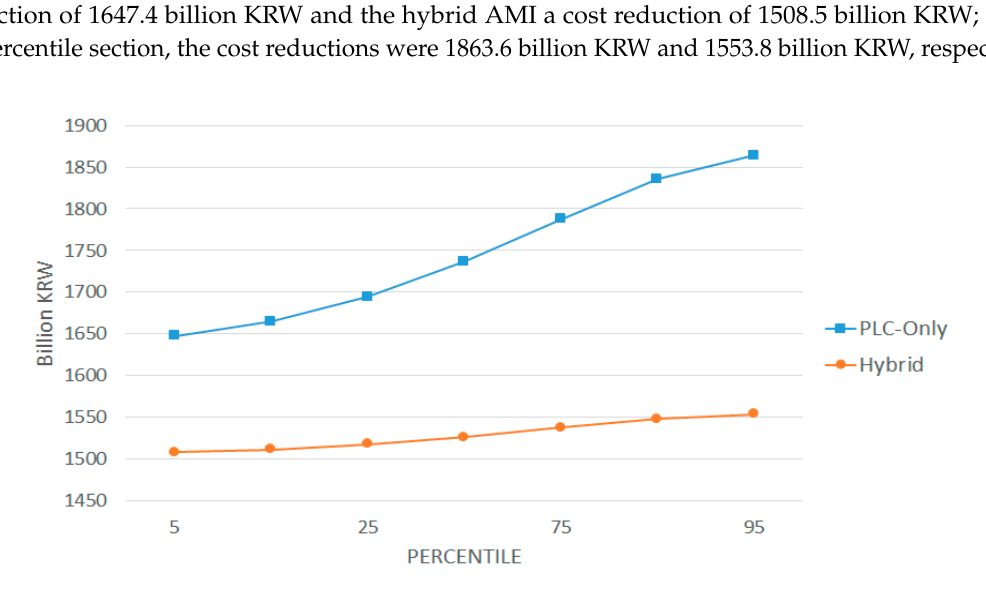
Figure 9. Sensitivity Analysis Result per Deployment Method.